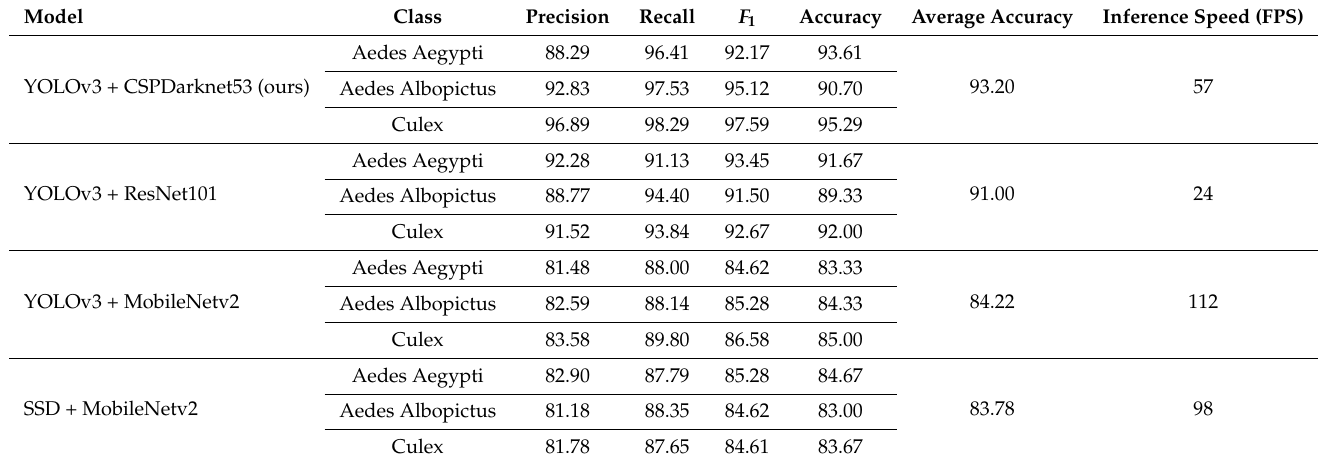
Table 6. Comparison with other models.